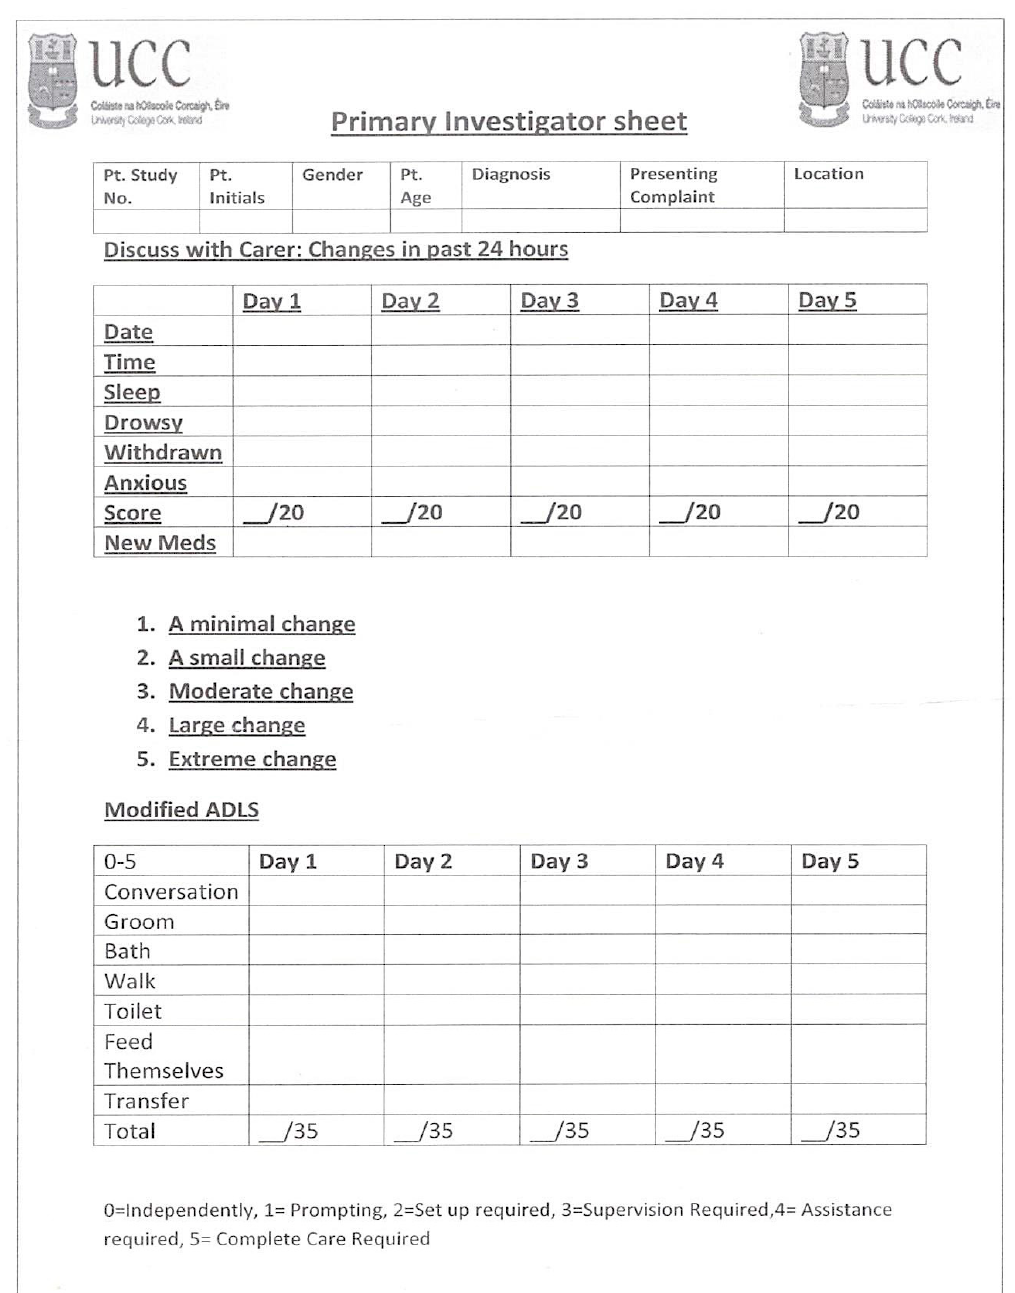
Figure A2. Investigator score sheets documenting clinical status.